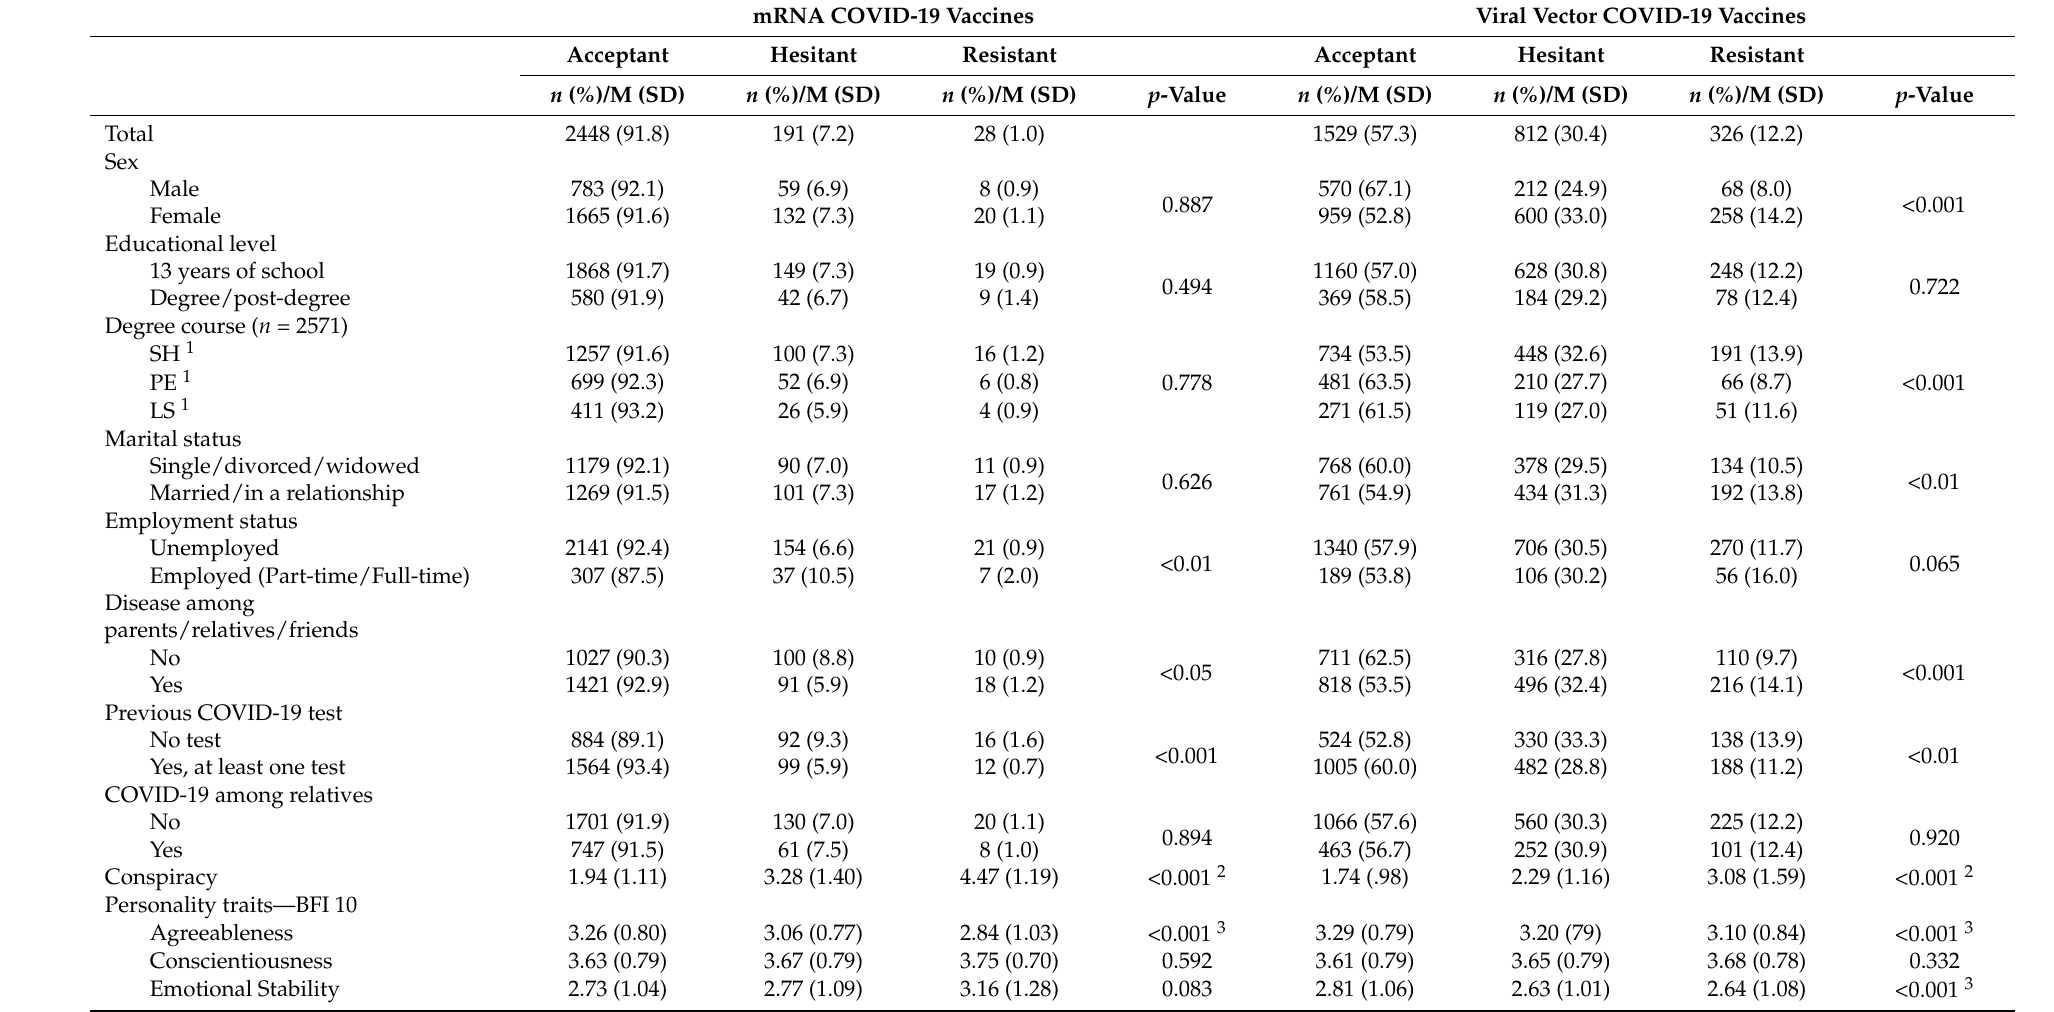
Table 2. Variables associated with mRNA and viral vector COVID-19 vaccine hesitancy,